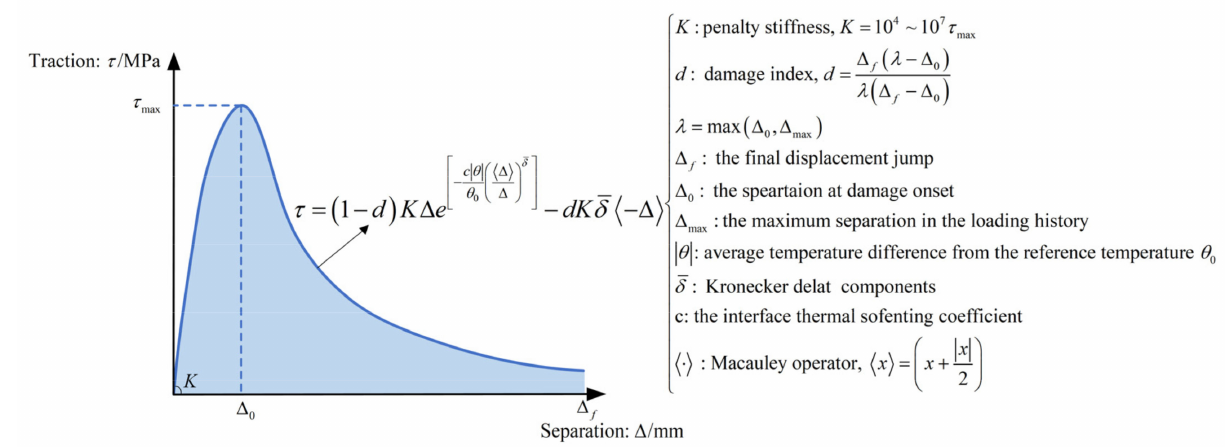
Figure 12. Coupled cohesive traction–separation law.